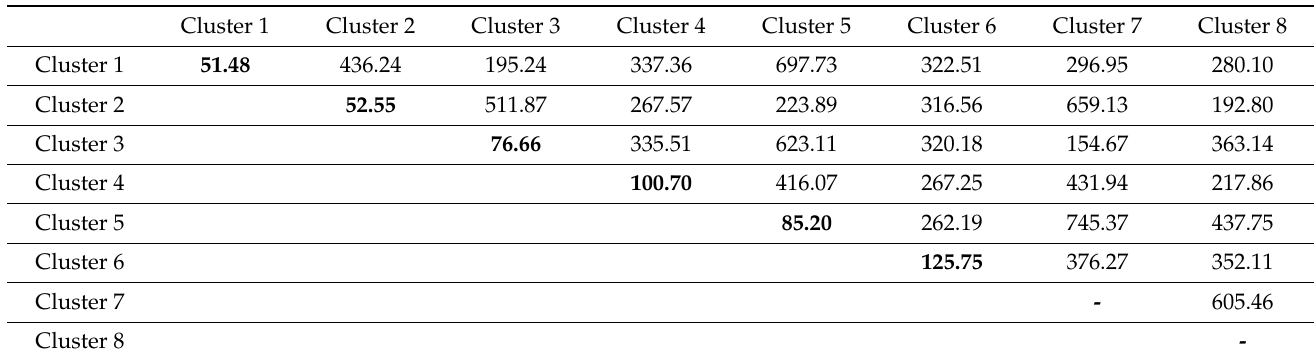
Table 3. Intra-(bold face) and inter-cluster (plain text) Euclidean distances between the eight clusters identified with Tocher’s clustering approach. Since clusters 7 and 8 are made of one accession, the within-cluster distance is not obtainable (-).